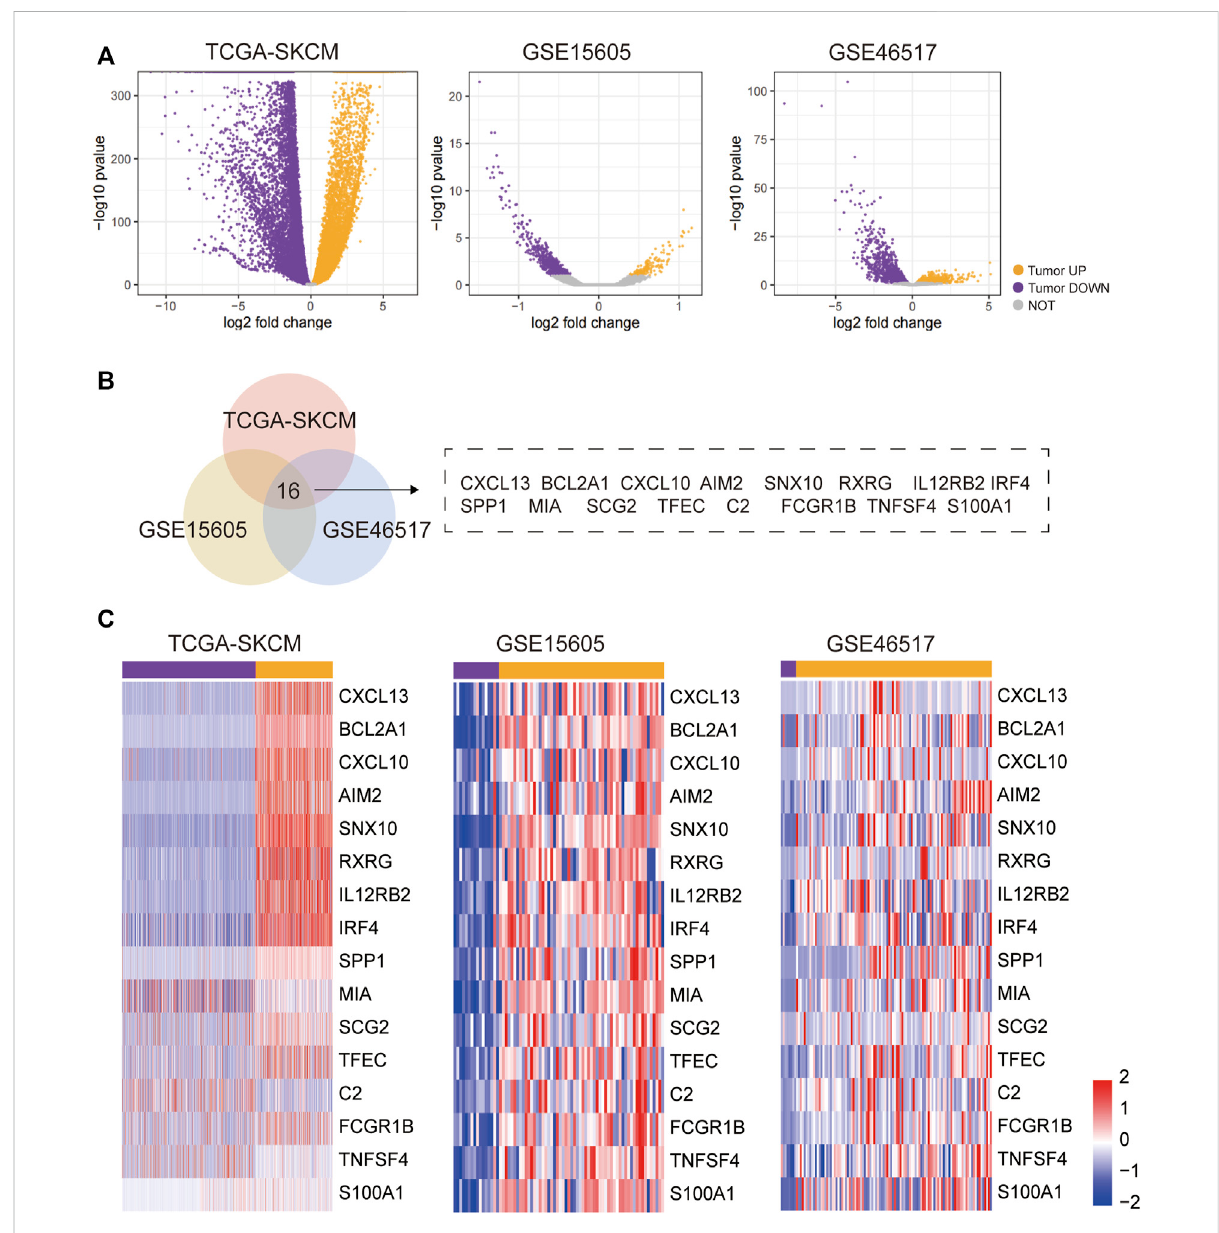
FIGURE 1 DEG identi fi cation and analysis. (A) Volcano plot of DEGs in TCGA-SKCM, GSE15605, and GSE46517 datasets. (B) Venn diagram: Venn plots of DEGs intheTCGA-SKCM, GSE15605,and GSE46517datasets,with theoverlappedpart representing the16commonDEGs inthethree data sets. (C) The 16 overlapping parts portray the DEGs that are shared by the three data